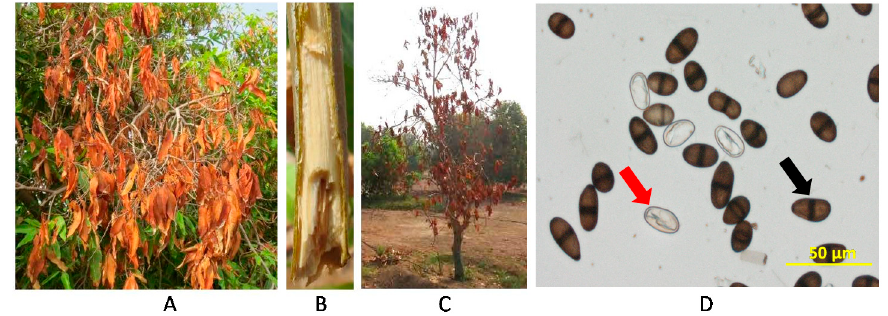
Figure 1. Naturally-infested mango trees showing symptoms of dieback disease and morphological phenotypes of Lasiodiplodia theobromae conidia. Symptoms on ( A ) leaves; ( B ) twigs; ( C ) whole tree; and ( D ) L. theobromae hyaline, aseptate immature (red arrow) and brown, 1-septate, thick-walled mature conidia (black arrow) from a 10-day old potato dextrose agar (PDA) culture.